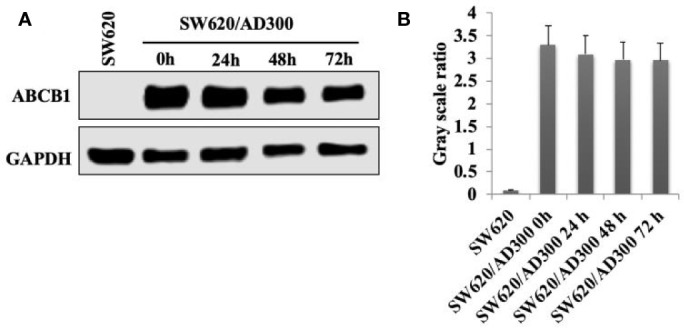
The effect of the incubation of sapitinib on ABCB1 expression in SW620/Ad300 cancer cells. (A) Western blots. (B) Quantification of the Western blot bands.